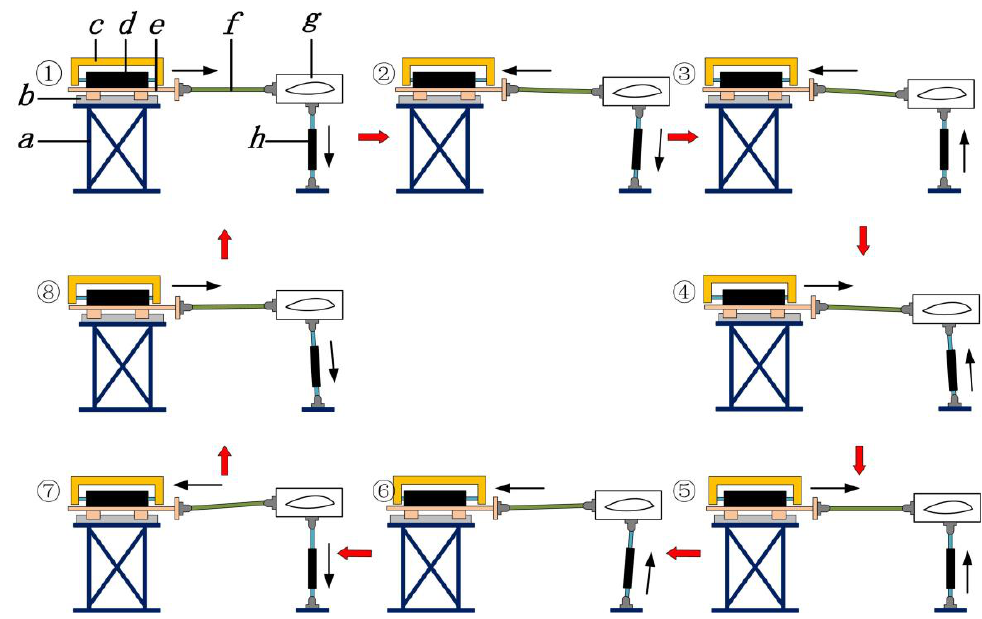
Figure 10. Movement process of blades in a single cycle when using “virtual-mass” biaxial fatigue testing device. a is foundation, b is slide rail, c is virtual mass, d is hydraulic loader of edgewise and piston rod, e is slide platform, f is push rod, g is cross section of blade and fixture, h is hydraulic loader of flapwise.